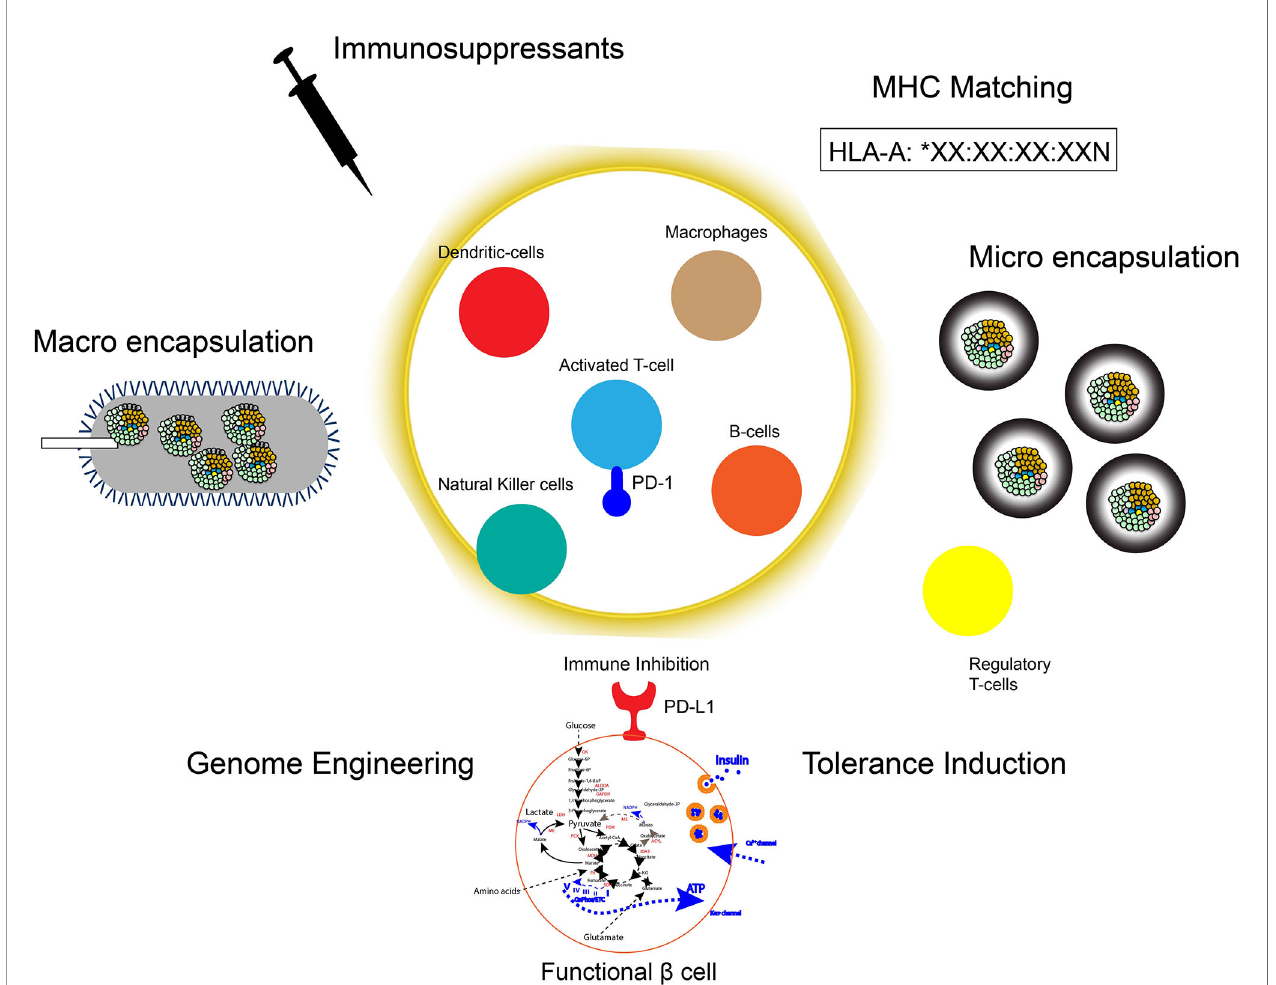
FIGURE 2 | Strategies for immune protection of hPSC derived islets. To protect the transplanted hPSC derived islets graft: 1. Immunosuppressants, 2. Macro encapsulation devices (e.g. Theracyte Device), 3. Micro encapsulation gels (e.g. Alginate-coating), 4. MHC-matching, 5. Genome engineering of immune checkpoint molecules and/or HLAs, 6. Induction of immune tolerance by preconditioning or trained